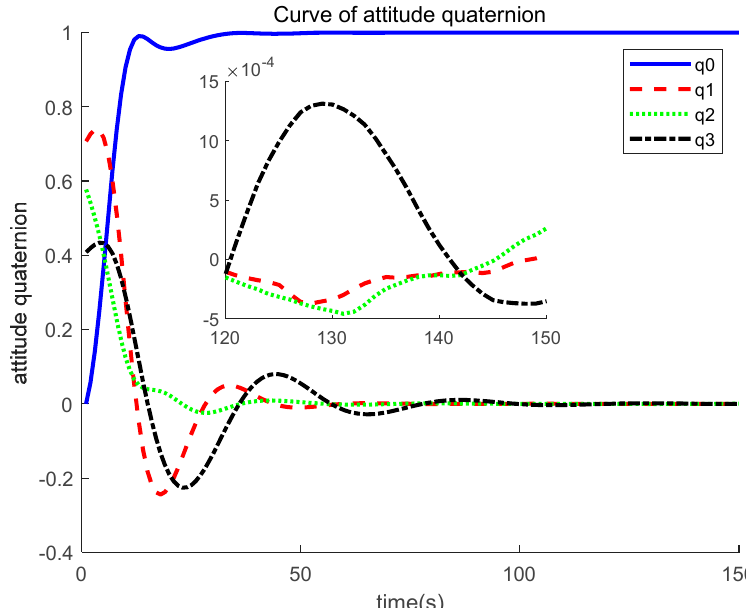
Figure 2. Curve of attitude quaternion under a standard PID controller.